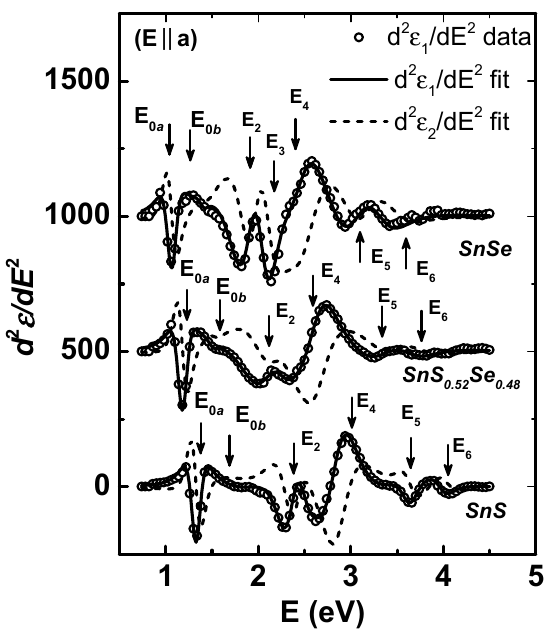
Figure 8. Best fits of the second derivatives of ε 1 (solid lines) and ε 2 (dashed lines) for the zigzag direction. The circles are the numerically calculated derivatives of the data. The number of points is reduced for clarity. The spectra are shifted by increments of 500 from that at x = 1.